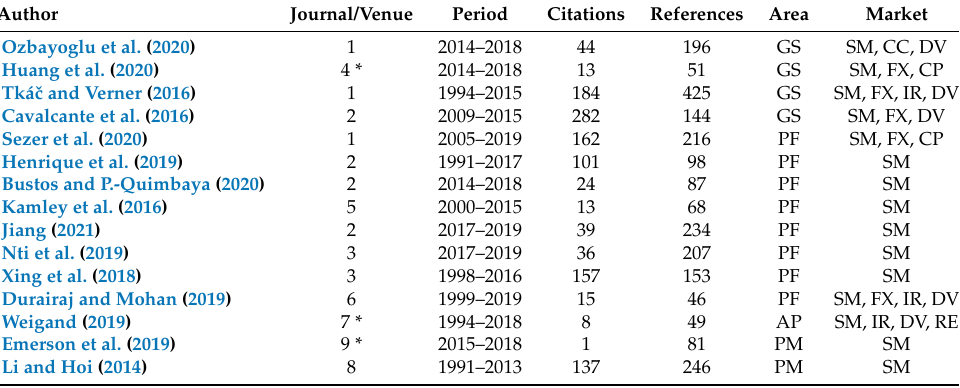
Table 1. List of review articles in the last five years, both general and specific financial areas. General Survey (GS), Price Forecasting (PF), Asset Pricing (AP), Portfolio Management (PM), Stock Market (SM), Exchange Rates forecasting (FX), Interest Rate forecasting (IR), Criptocurrencies